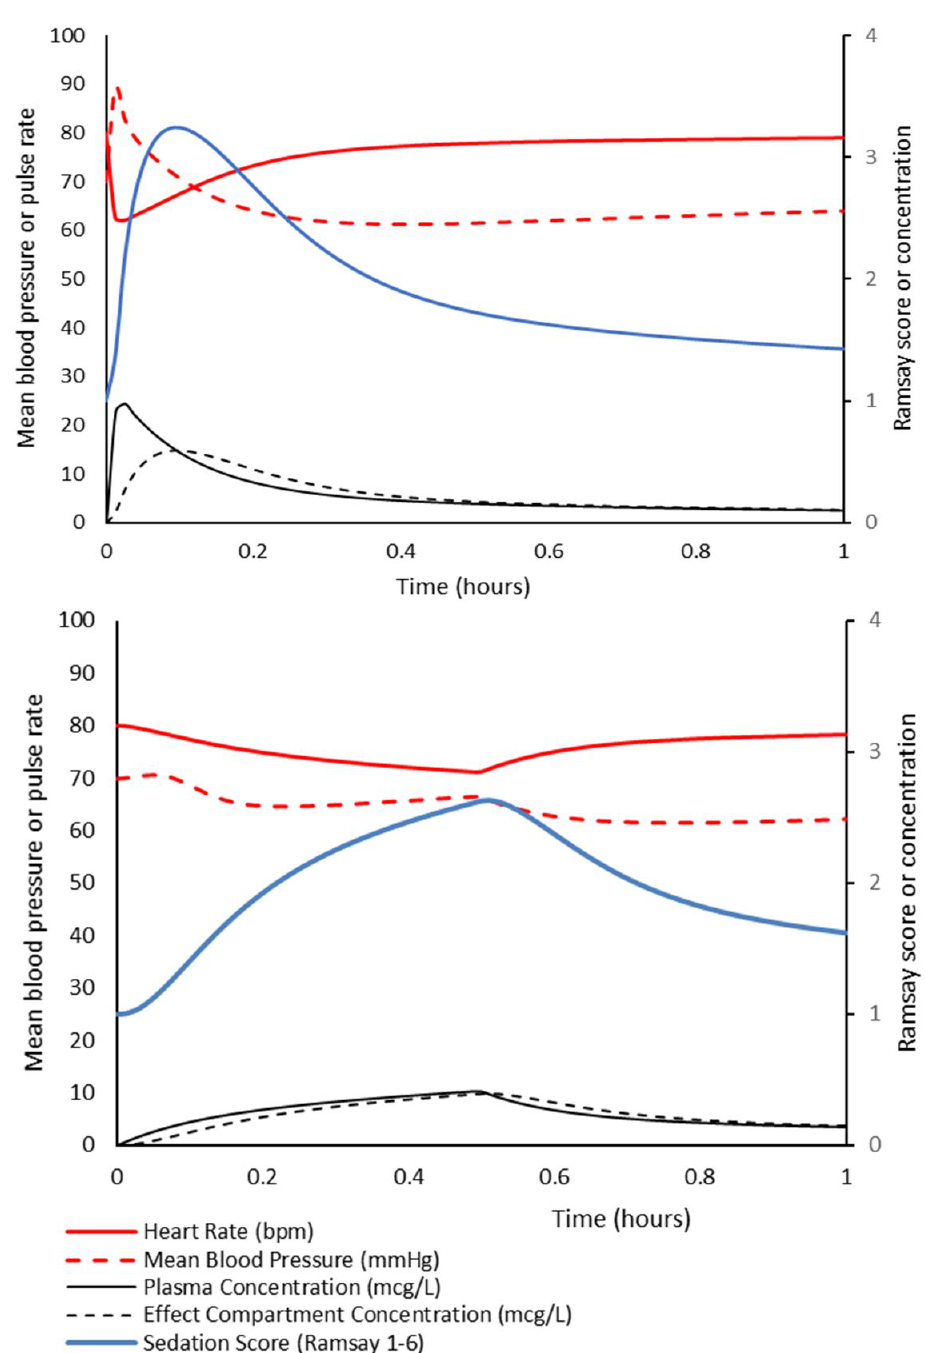
Figure 1. Illustrative simulation of dexmedetomidine 0.4 mg/kg given to a 5-year-old child. The drug in the upper panel was given as a rapid bolus. The lower panel shows the same dose administered as an infusion over 30 min.